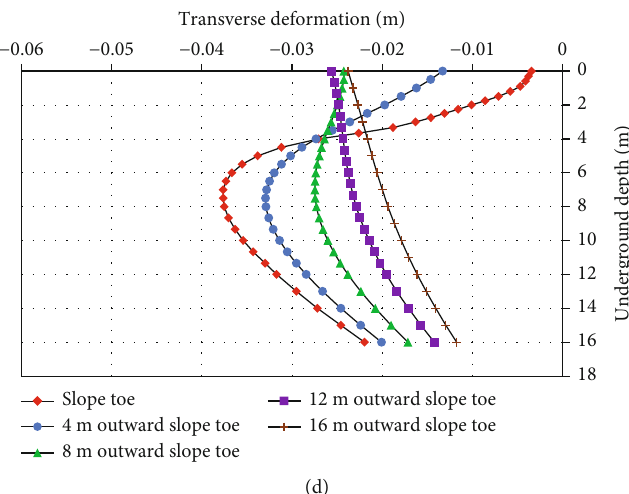
Figure 7: Transverse deformation-underground depth curves at di ff erent distances outside slope toe in soft soil with variable replacement thicknesses. (a) Replacement thickness = 1 : 5 m. (b) Replacementthickness = 2 : 0 m. (c) Replacement thickness = 2 : 5 m. (d) Replacement thickness = 3 : 0 m.